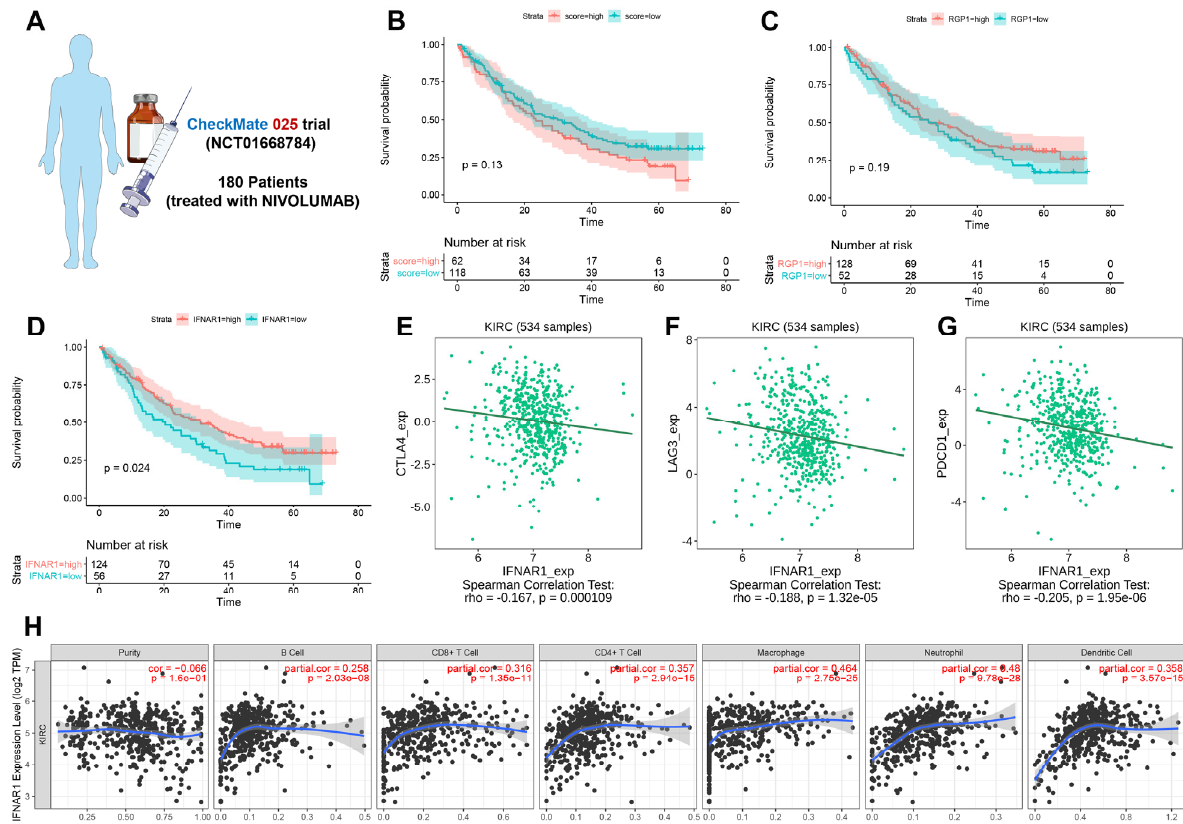
Figure 6. The correlation between the expression level of IFNAR1 with immunotherapy response and immune microenvironment. ( A ) Summary of the patients in external validation. ( B ) Overall survival curves of high IE score group and low IE score groups using the Kaplan–Meier method.